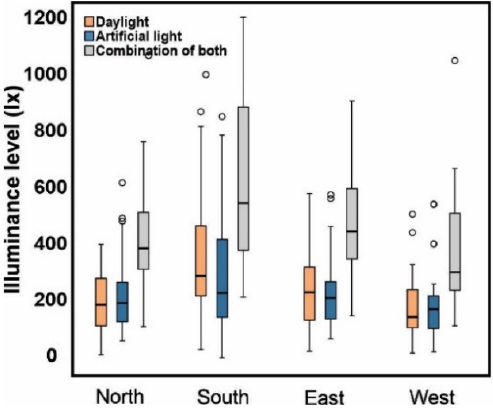
Figure 3. On-site measured illuminance in the studied buildings separated by window orientation. Extreme outliers are marked with an asterisk and circles